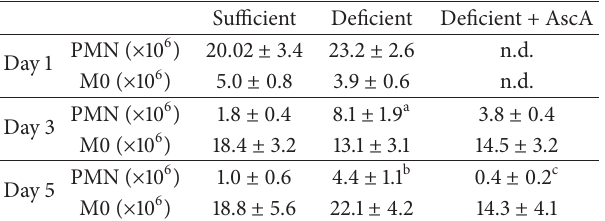
Table 2: Differential cell counts from peritoneal exudates following thioglycollate-induced peritonitis ( 𝑁 = 6–8 mice/group, n.d. = not